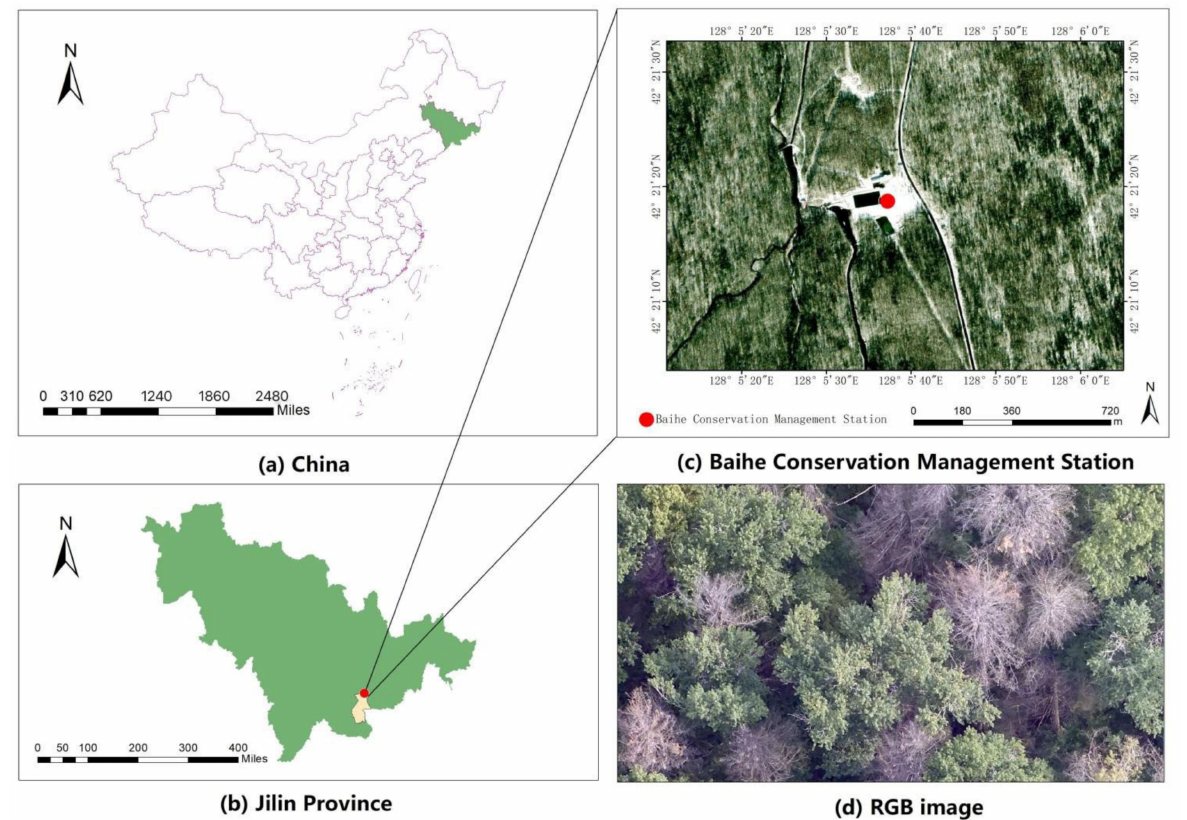
Figure 1. Geographical location and image map of the study area. ( a ) Map of China with Jilin Province in green color; ( b ) map of Jilin Province with the Changbai Mountains in beige color and the study area in red color; ( c ) geographical location of the Baihe Conservation Management Station; ( d ) RGB image of the study area obtained by